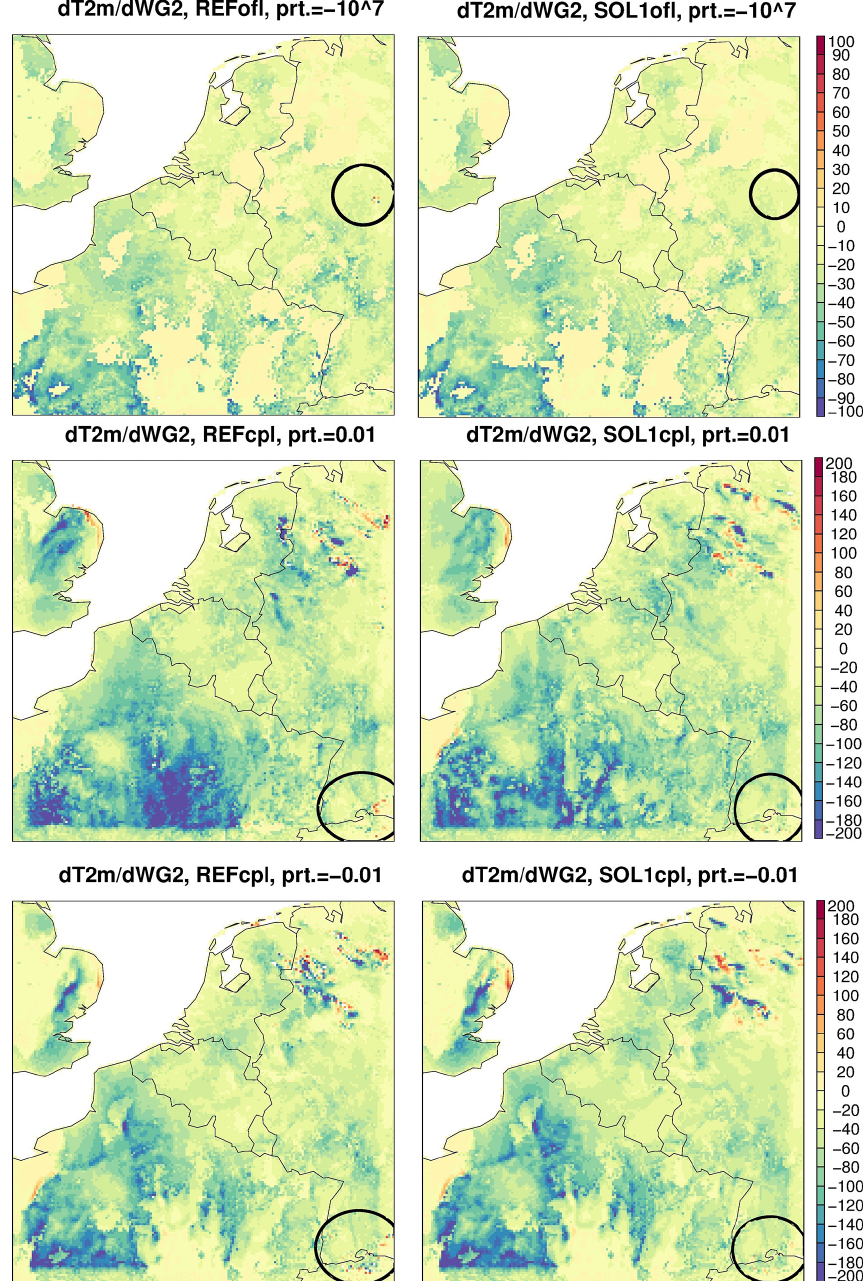
Figure 11. Map of the Jacobian and gain value for δT 2m /δW 2 for 6 July 2010 at 18:00UTC for REF (left) and FIL (right) of the offline (first row) and coupled (second and third rows) versions. The perturbation size for the offline runs was 10 − 7 and, for the coupled runs, 10 0 . 01 (second row) and 10 − 0 . 01 (third